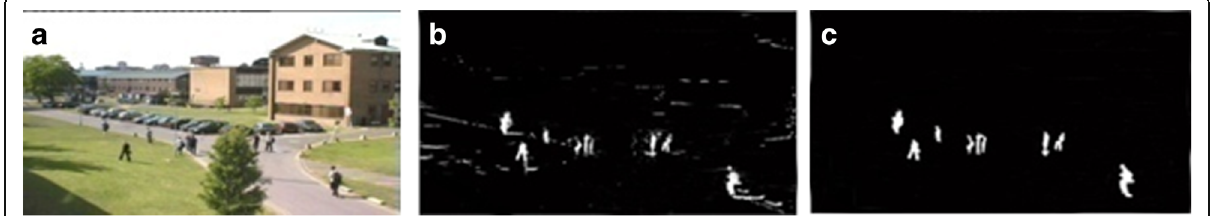
Fig. 11 Effect of post processing operation ( a ) The original image, ( b ) differentiated image, ( c ) differentiated image after post